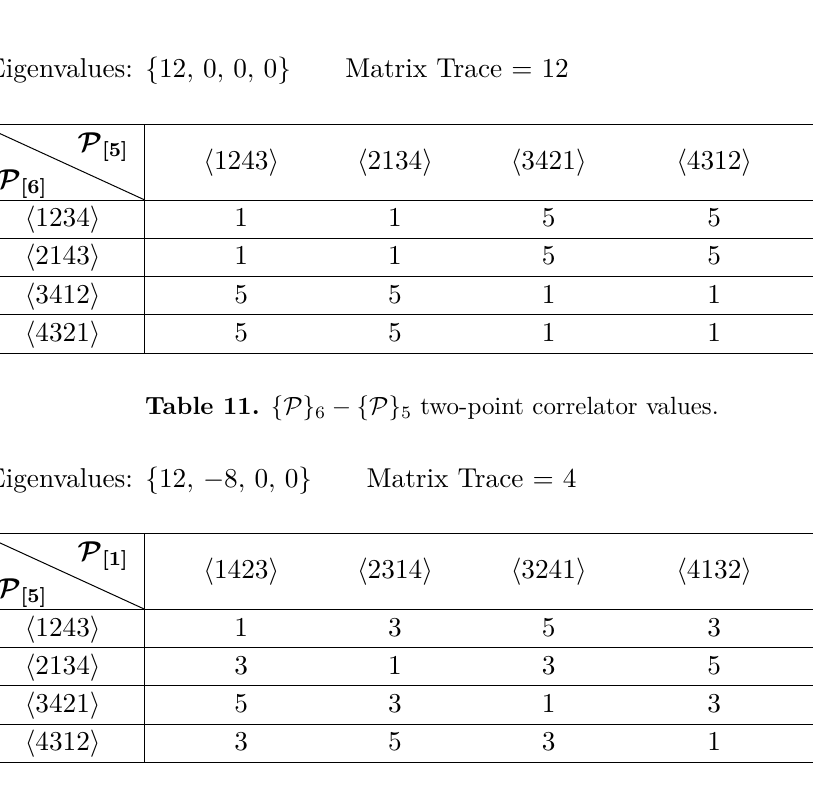
Table 12. {P} 5 − {P} 1 two-point correlator values.